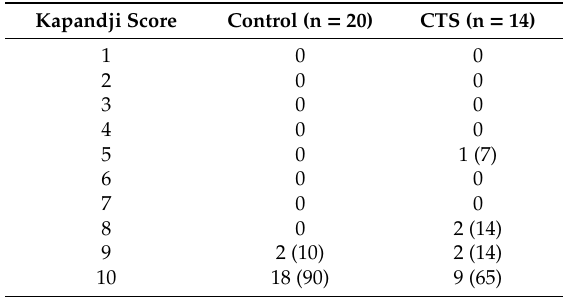
Figure 7. Receiver operating characteristic curves of our device method and the Kapandji score. The black dot indicates the cutoff point. 4. Discussion Using a device combining two CNT sensors, we evaluated the correlation of expansion and contraction of sensors during thumb palmar abduction movement. A moderate negative correlation was recognized in the control group, but in the CTS group, ACC was significantly higher and the correlation was lost. We have previously successfully measured thumb opposition movements non-invasively using a gyroscope [24,27]. The previous method had limitations: the device could interfere with the thumb movement and be adversely affected by skin stretching. I n this study, we focused on the CNT sensor, which is thin and elastic enough to fit the skin stretching, and easy to adapt to the joint's shape. A